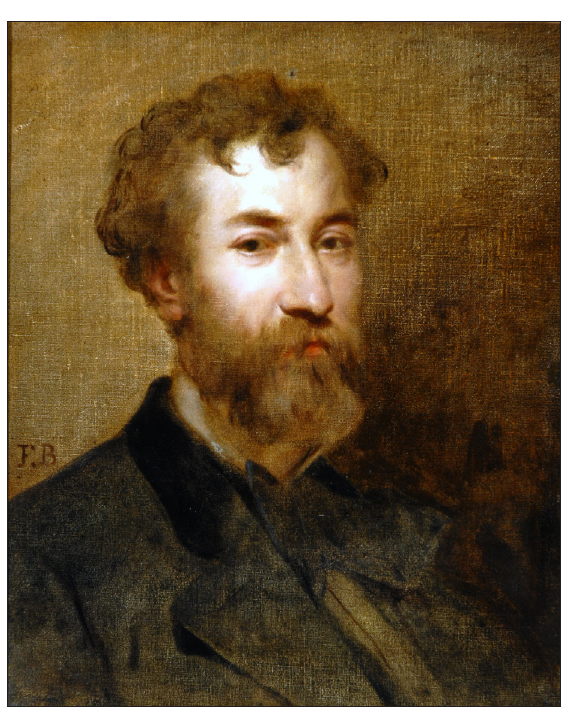
Fig. 5 : Faustin Besson, Lorédan Larchey (1831–1902) , c. 1860, oil on